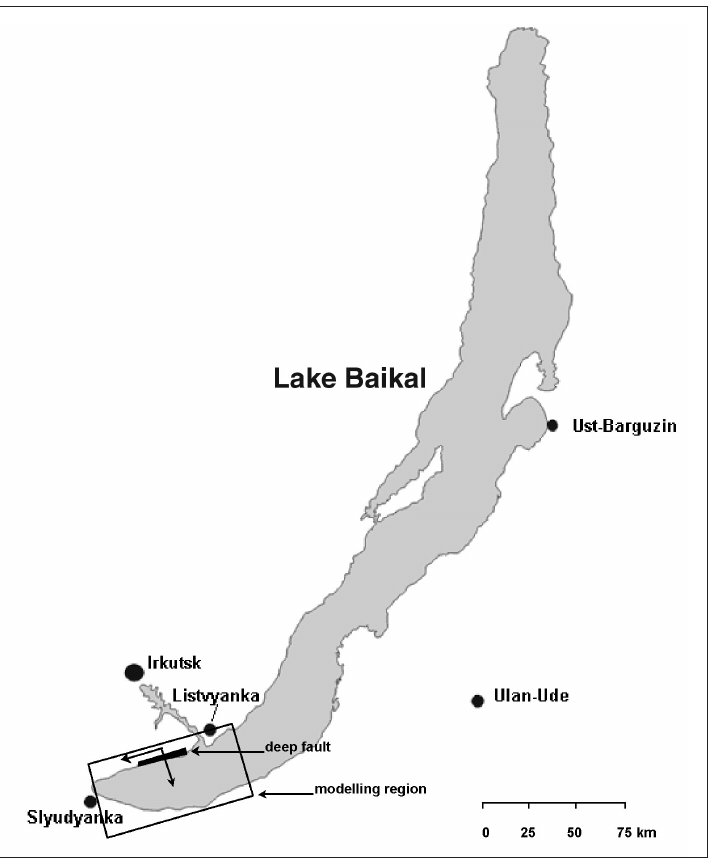
Fig. 1. Map of the region of Lake Baikal. Modelling region is marked with a rectangle. The fault is marked with a thick